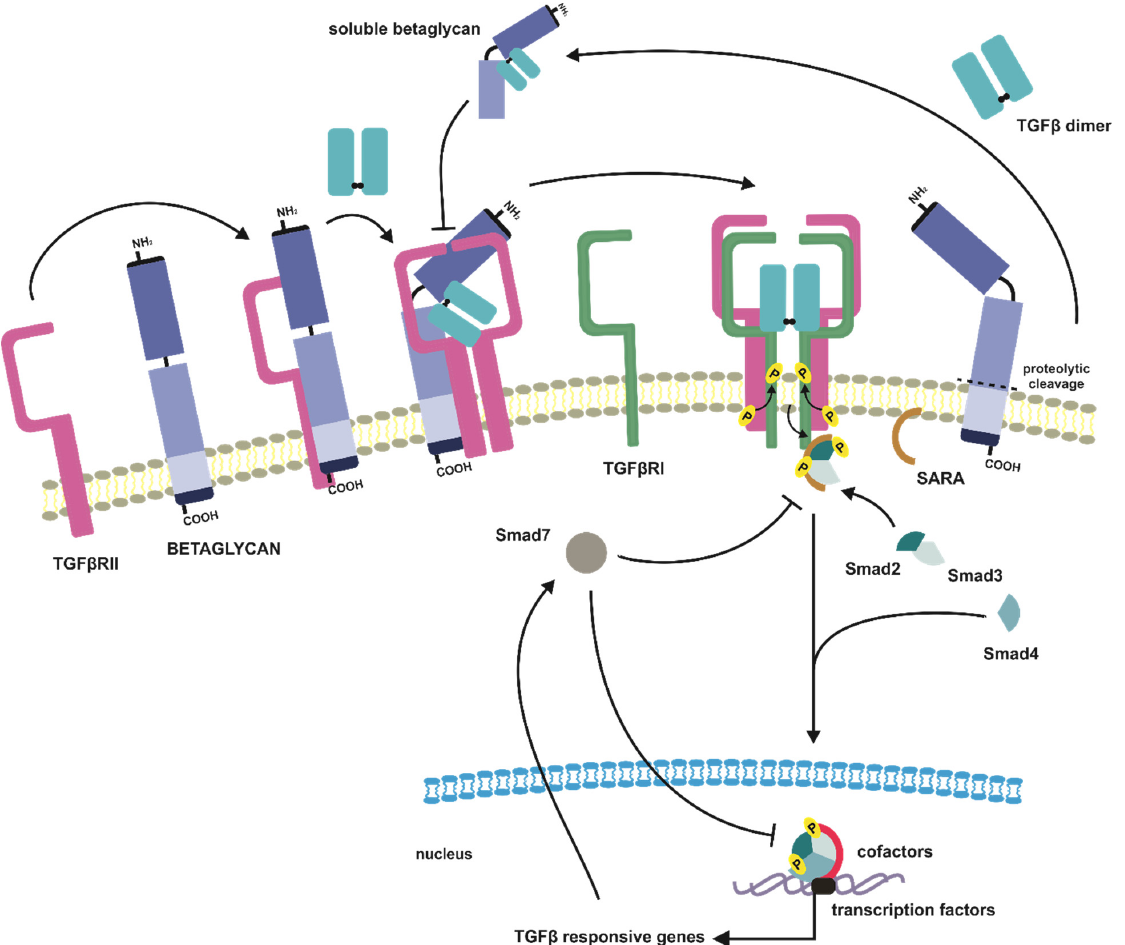
Figure 5. Canonical TGF β signaling mediated by TGF β co-receptor betaglycan and soluble betaglycan formed after proteolytic cleavage. TGF β ligands presentation to the dedicated TGF β Rs includes the formation of a binary complex between betaglycan and TGF β dimer, which potentiates binding of TGF β RIIs. In turn, once bound, TGF β RIIs lead to recruitment of TGF β RIs, with a simultaneous displacement of betaglycan from signaling complex. Betaglycan can also modulate TGF β signaling due to its ectodomain shedding. A soluble form of betaglycan effectively sequestrates TGF β dimers, thus diminishing pathway activation.